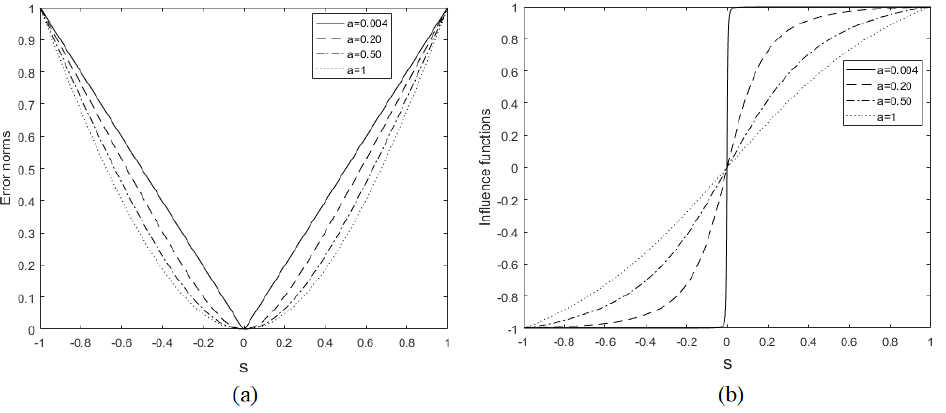
Figure 2. ( a ) Error norm function, Equation (15), and ( b ) influence function, Equation